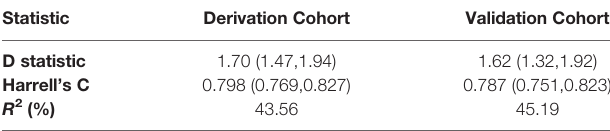
Predictionmodel:age,sex,BMI,alcoholdrinkingstatus,andteadrinkingstatus.Dstatistic and Harrell ’ s C: evaluate model discrimination ability, higher values mean better discrimination ability; R 2 : the variance of the model interpreted, higher value means better.